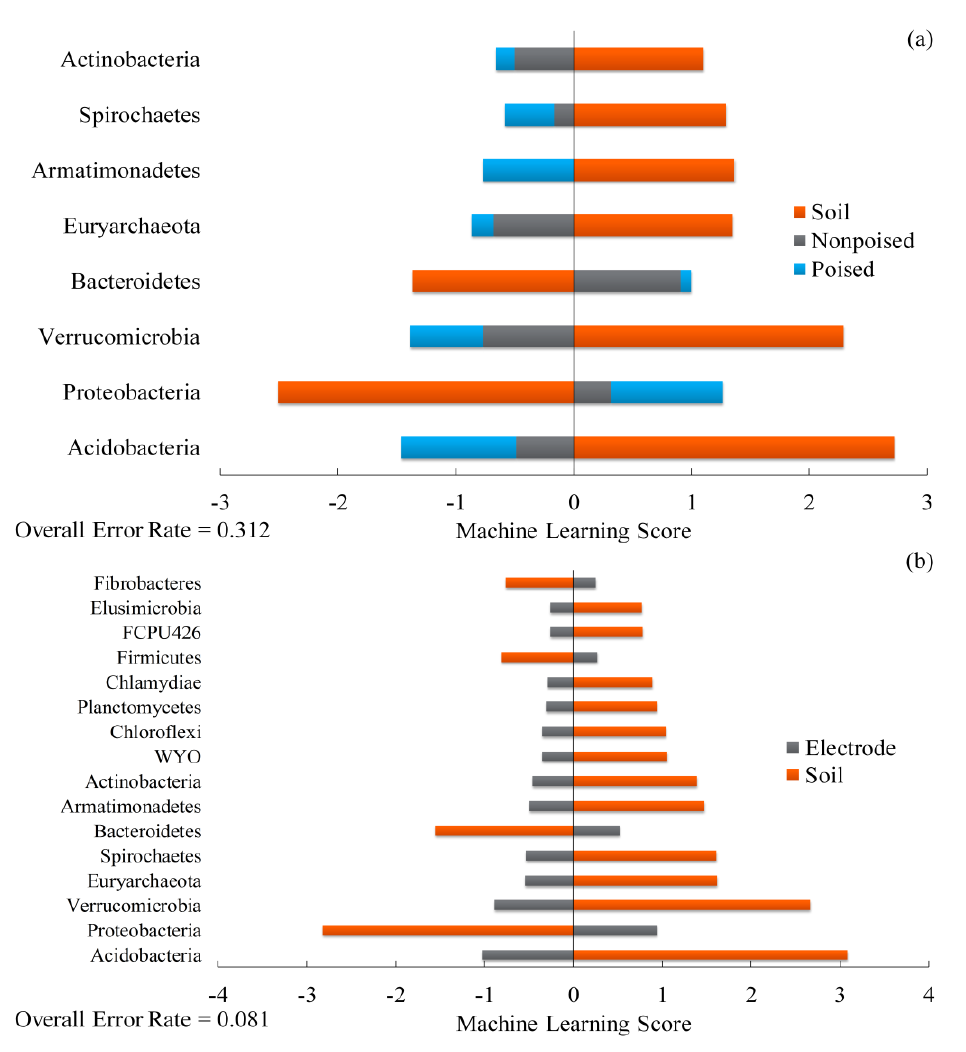
Figure 5. Machine learning analysis of soil and biofilm communities from shallow samples reveals the major difference is between communities with an electrode and those without one. When communities are grouped into soil, nonpoised electrodes, and poised electrodes ( a ), of the 30 phyla used to create the algorithm, there are eight phyla that are highly predictive of sample type, however the error rate is high (0.312) and trends (positive or negative scores) are always the same between nonpoised and poised electrodes. Grouping all electrode samples (both nonpoised and poised) together ( b ) results in a better ability to predict sample history (error rate = 0.081). In addition, there are 43 phyla used to predict sample history and, of the 16 most predictive phyla, higher abundance of 12 phyla predict the sample to be from a soil